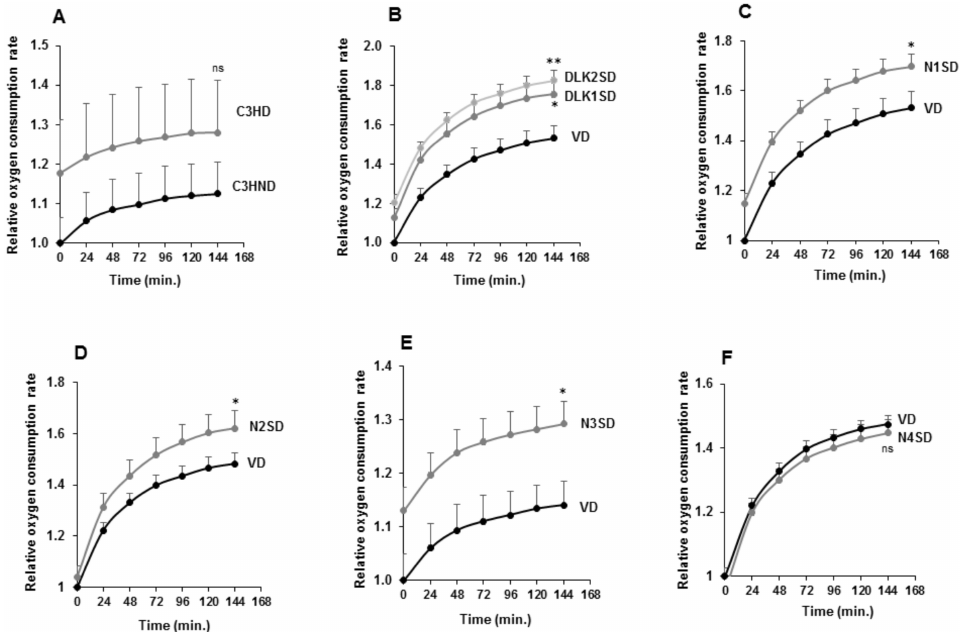
Figure 7. Oxygen consumption rate (OCR) in C3H10T1 / 2 adipocytes overexpressing Dlk or Notch genes. ( A ) Relative oxygen consumption rate (OCR) in non-di ff erentiated (C3HND) and di ff